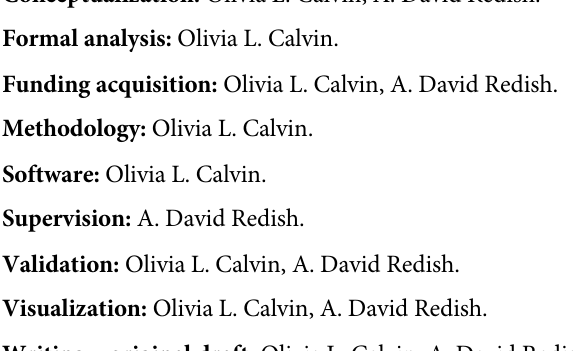
S2 Fig. Across Study Metaanalysis of the Relationships Between the Error Rates on Differ- ent Trial